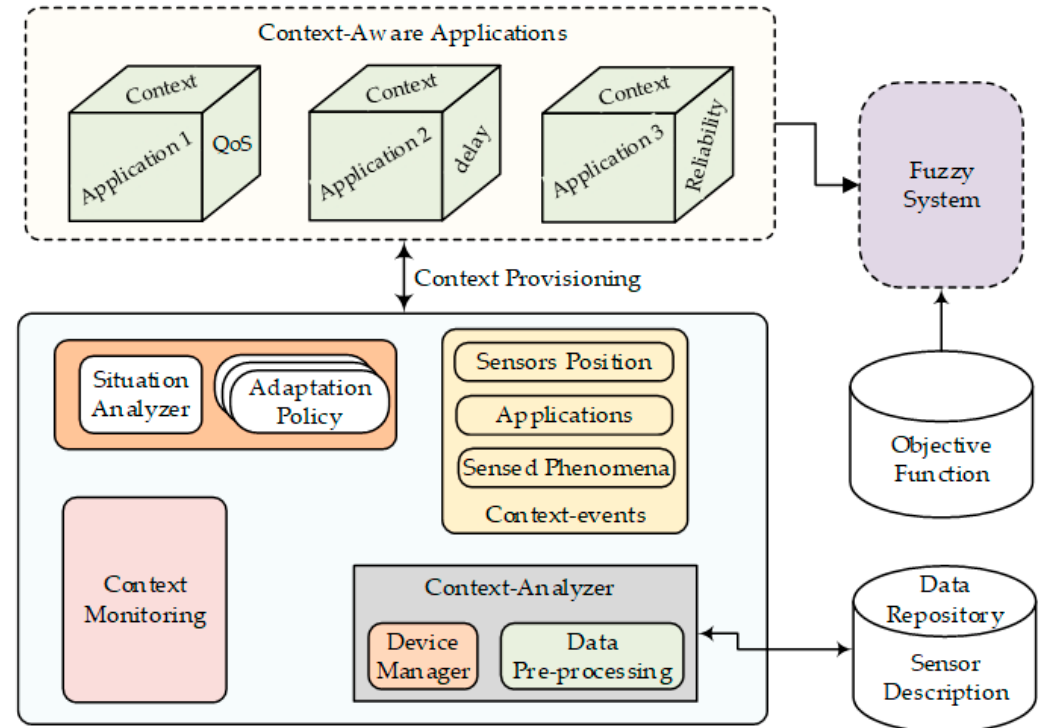
Figure 9. A simple functional context model of context-oriented objective function